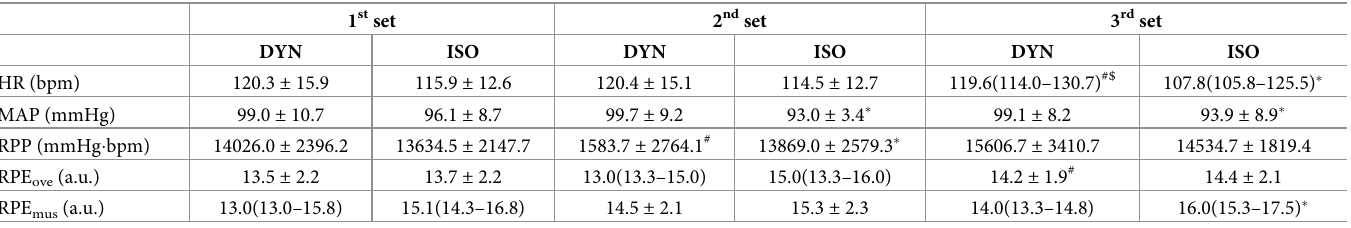
Table 2. Cardiovascular, haemodynamic and perceived exertion responses to dynamic contraction protocol (DYN) and isometric contraction protocol